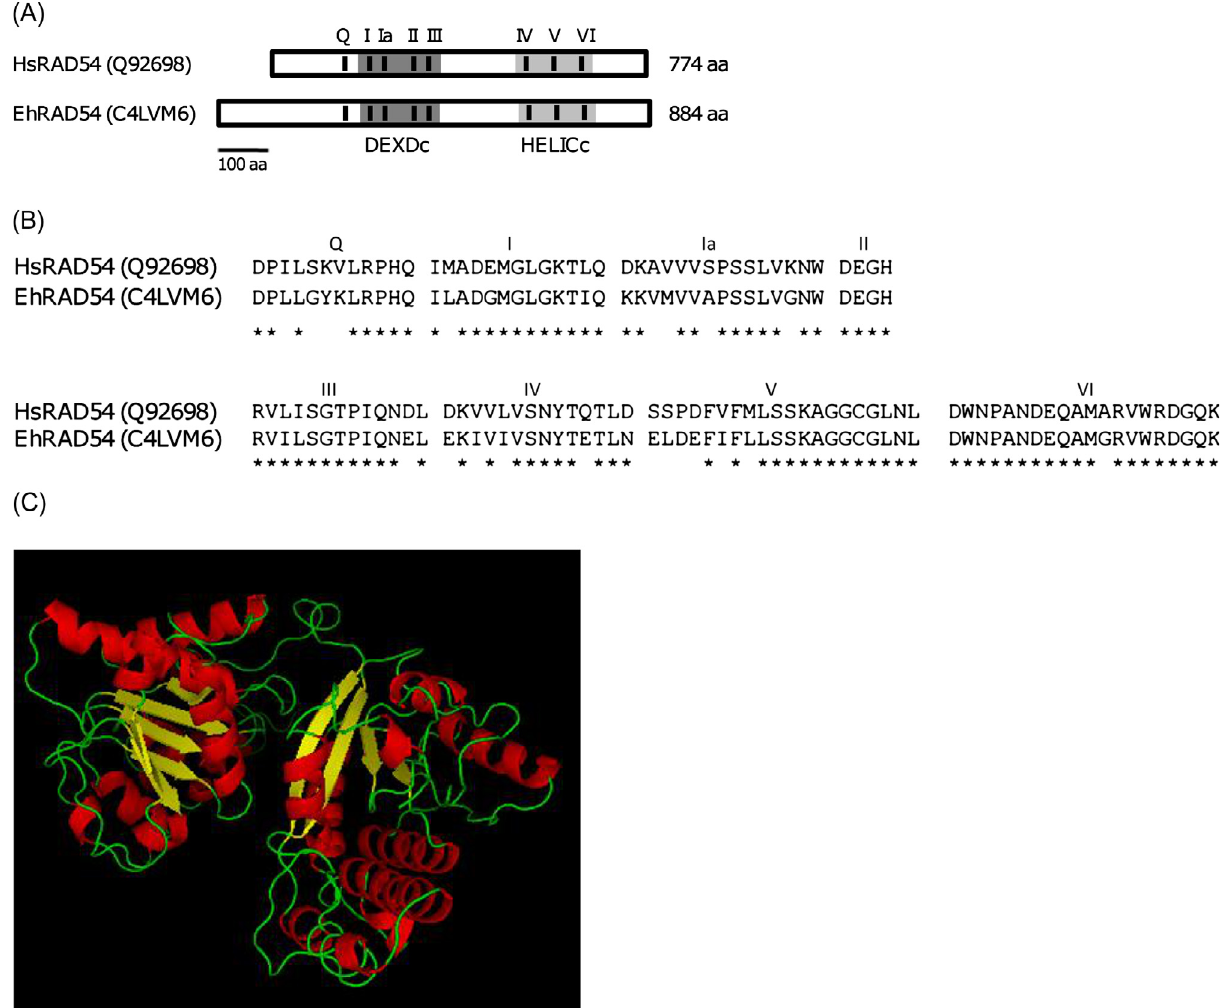
Figure 1. Molecular characteristics of EhRAD54 in E. histolytica (Eh) and Homo sapiens (Hs). (A) Schematic representation. Numbers at the right indicate the size in amino acids (aa) for each protein. The scale is at the bottom. (B) Alignment of conserved motifs. Asterisks indicate identical aa. (C) Predicted 3D model for EhRAD54. Accession number in UniProt Knowledgebase (UniProtKB) is indicated for each